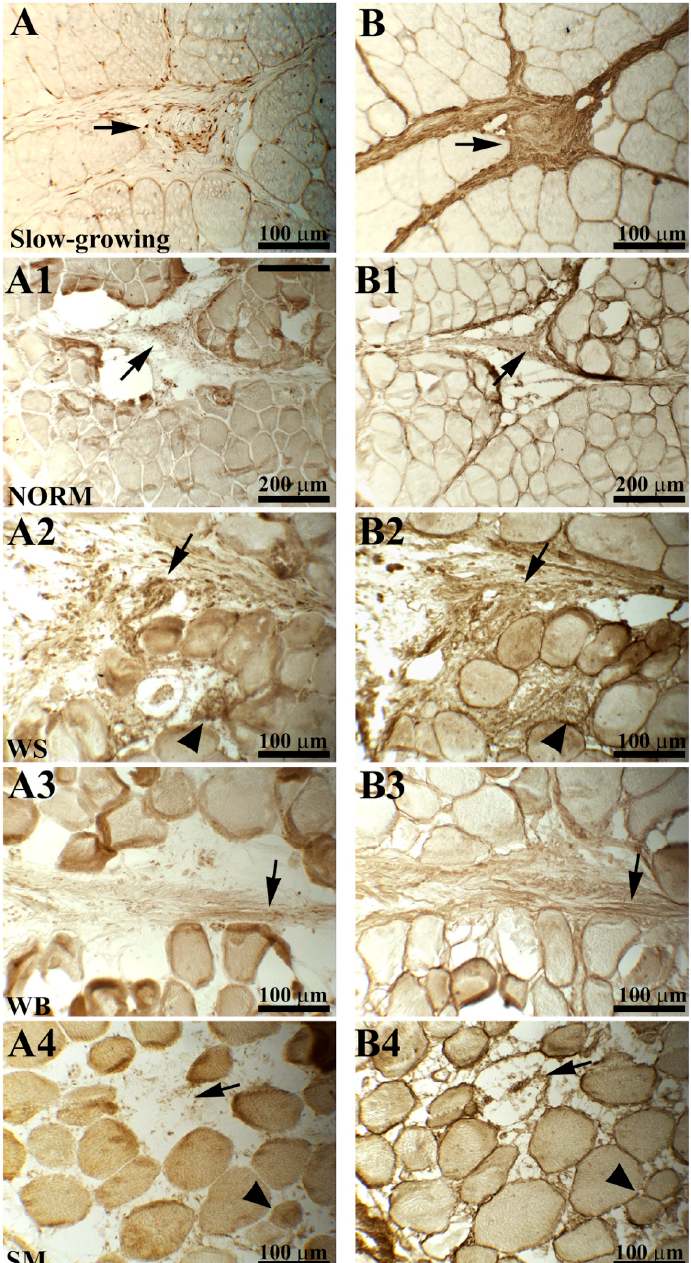
Figure 2. Serial cross-sections of chicken pectoralis major (PM) muscles belonging to a fast-growing genotype classified as normal cases (NORM) and those affected by white striping (WS), wooden breast (WB), or spaghetti meat (SM) abnormalities showing the immunoreaction to procollagen type III ( A–A4 ) and collagen type III ( B–B4 ) antibodies. Immunoreactivity to procollagen type III was almost